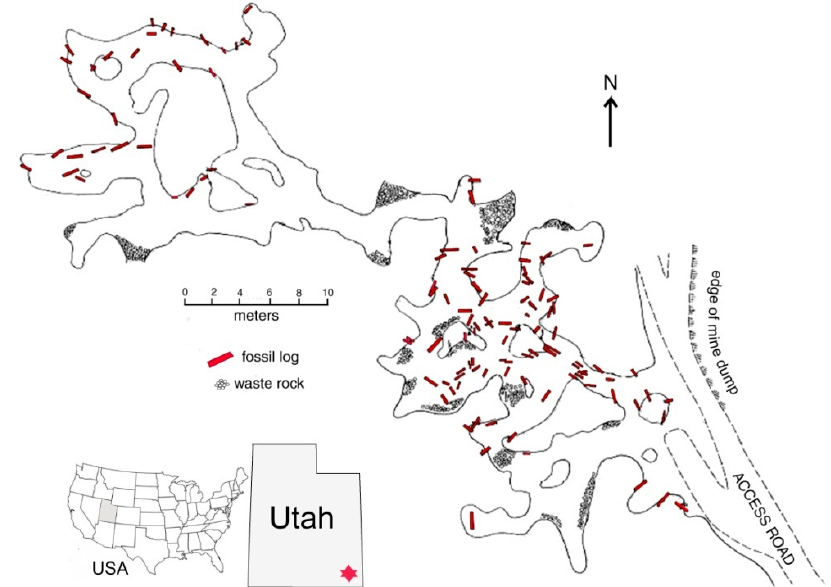
Figure 1. Fossil logs in Verdure Mine, Montezuma Canyon, San Juan County (UT, USA). Adapted from [6].